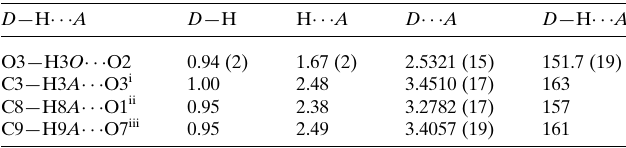
Table 1 Hydrogen-bond geometry (A˚ , (cid:2) ).